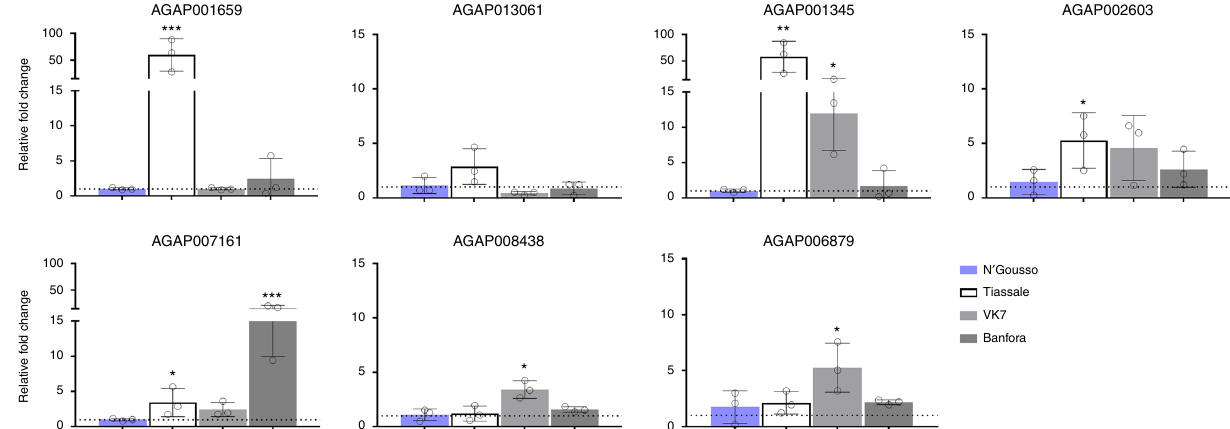
Fig. 2 qPCR analysis of top insecticide resistance candidates from multiple resistant populations. qPCR results of three 3 – 5 day old, unexposed, pyrethroid resistant Anopheles populations compared to the lab susceptible N ’ Gousso, three biological replicates and three technical replicates were used for each gene. Relative fold change ( y ), and resistant populations ( x ). Standard deviation bars are shown, with signi fi cance * p ≤ 0.05, ** p ≤ 0.01, *** p ≤ 0.001 as calculated by ANOVA with Dunnett ’ s post hoc